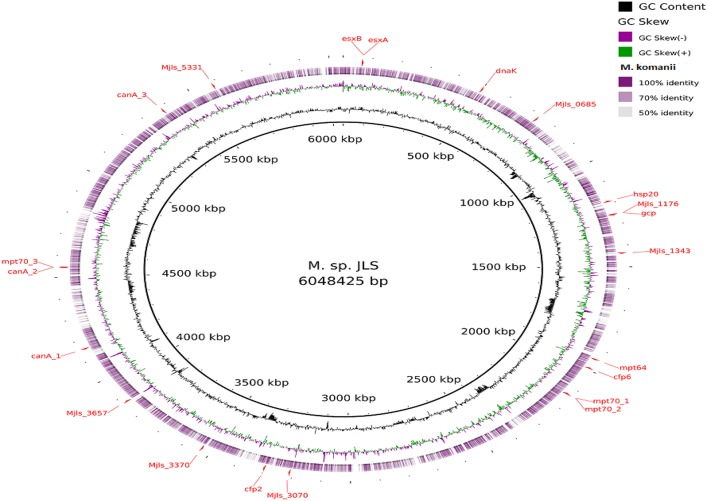
Alignment of M. komanii sp. nov. predicted CDS regions to those of M. sp. JLS (CP000580.1) using BRIG. Immunogenic proteins of interest identified in M. sp. JLS are highlighted in red (esxB: locus tag Mjls_0060, product hypothetical protein; esxA: locus tag Mjls_0061, product 6 kDa early secretory antigenic targetEsaT6; hsp20: locus tag Mjls_1109, product heat shock protein Hsp20; Mjls_1343: locus tag Mjls_1343, product of polysaccharide biosynthesis protein; cfp6: locus tag Mjls_1885, product low molecular weight protein antigen 6; cfp2: locus tag Mjls_3145, product low molecular weight antigen; Mjls_5331: locus tag Mjls_5331, product lipoprotein antigen family protein; dnaK: locus tag Mjls_0449, product molecular chaperone DnaK;mpt64: locus tag Mjls_1842, product immunogenic protein MPB64/MPT64; mpt70_1: locus tag Mjls_2023, product beta-Ig-H3/fasciclin; mpt70_2: locus tag Mjls_2024, product beta-Ig-H3/fasciclin; mpt70_3: locus tagMjls_4307, product beta-Ig-H3/fasciclin; Mjls_1176: locus tag Mjls_1176, product peptidase M22, glycoprotease; gcp: locus tag Mjls_1178, product putative DNA-binding/iron metalloprotein/AP endonuclease; canA_1: locus tag Mjls_3936, product carbonic anhydrase; canA_2: locus tag Mjls_4306, product carbonic anhydrase;canA_3: locus tag Mjls_5131, product carbonic anhydrase; Mjls_0685: locus tag Mjls_0685, product alkyl hydro peroxide reductase/ Thiol specific antioxidant/ Mal allergen; Mjls_3070: locus tag Mjls_3070, product alkyl hydro peroxide reductase; Mjls_3370: locus tag Mjls_3370, product alkyl hydro peroxide reductase; Mjls_3657: locus tag Mjls_3657, product alkyl hydro peroxide reductase.